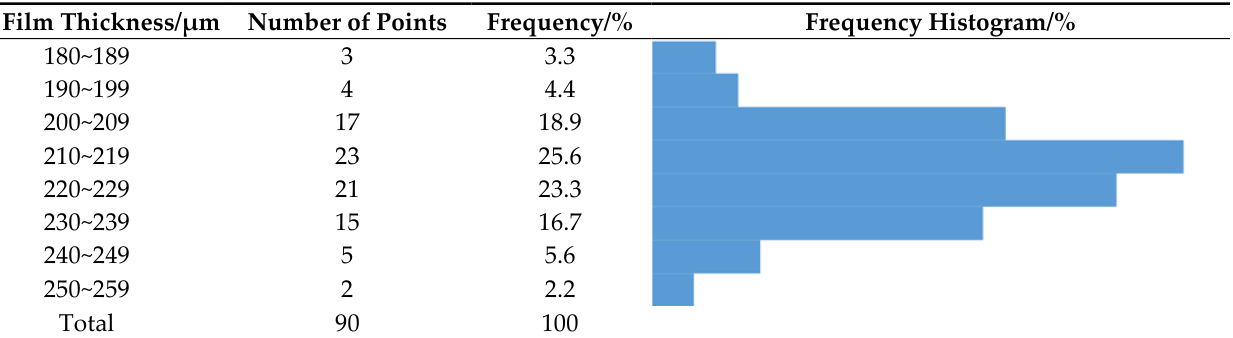
Figure 7. Painting operation by side suspension painting robot. Table 12. Distribution of dry film thickness. Table 12. Distribution of dry film thickness.